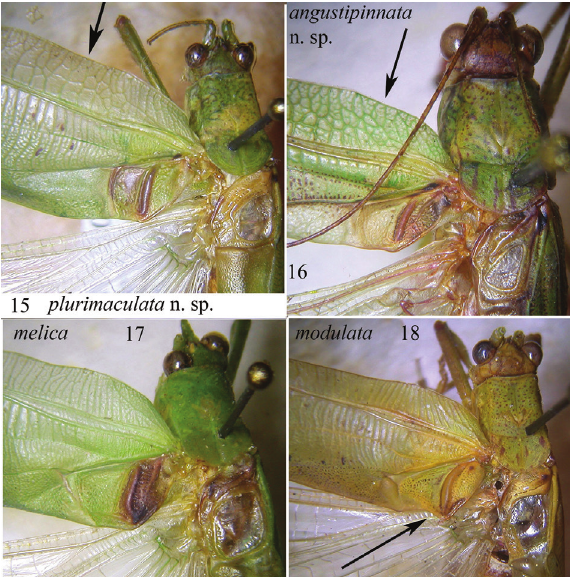
Figures 15–18. Stridulatory area of left tegmen and mirror of right tegmen of the male of Morgenia plurimaculata sp. n. (15) , M. angustipinnata sp. n. (16) , M. melica (17) and M. modulata (18) . Arrows in M. plurimaculata sp. n. and M. angustipinnata sp. n. show the net of small cells in costal area of their tegmina, while in M. modulata the protruding stridulatory